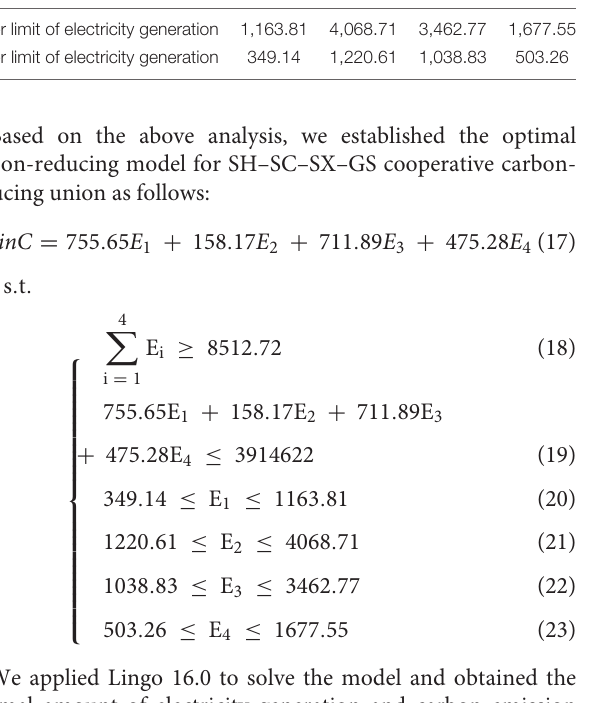
TABLE 5 | The limits of electricity generation in 2017 (108 kwh). SH SC SX